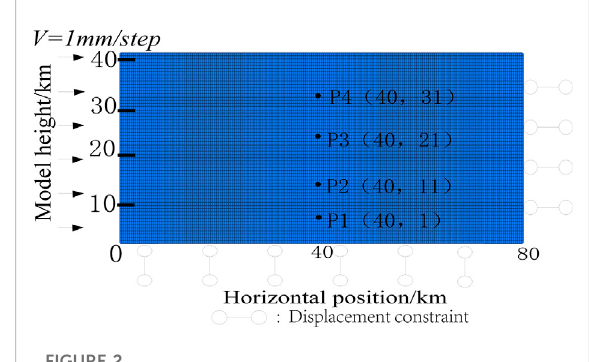
FIGURE 2 Boundary conditions and loading of the calculation